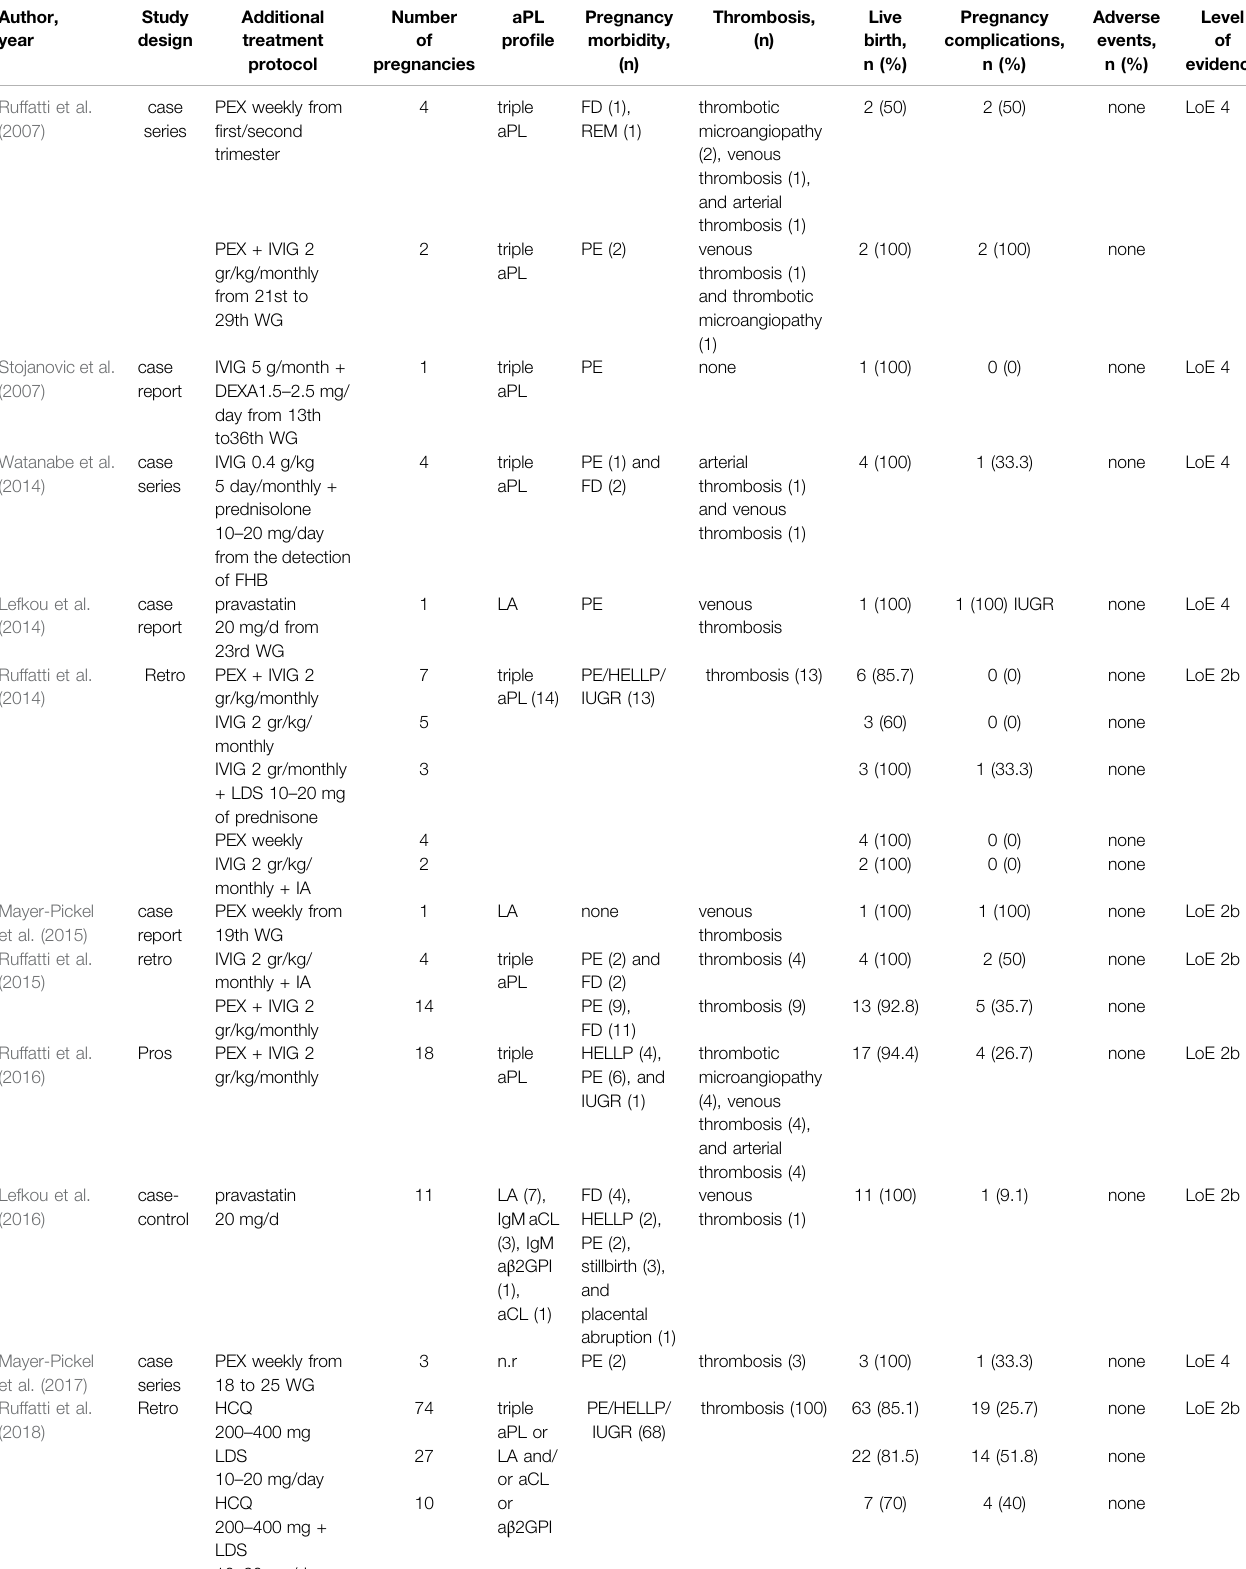
TABLE 2 | Studies investigating the effects of additional therapy in high-risk/refractory pregnancies in antiphospholipid syndrome. Author,